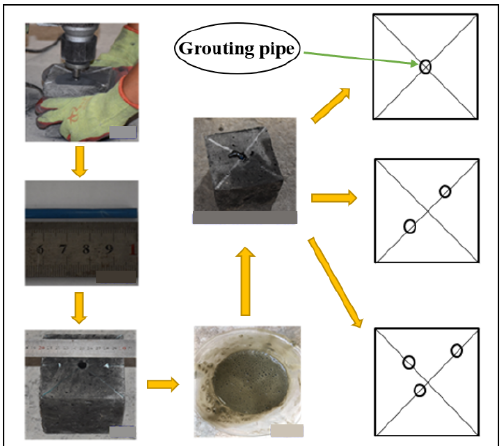
Figure 5. The process of making test pieces.